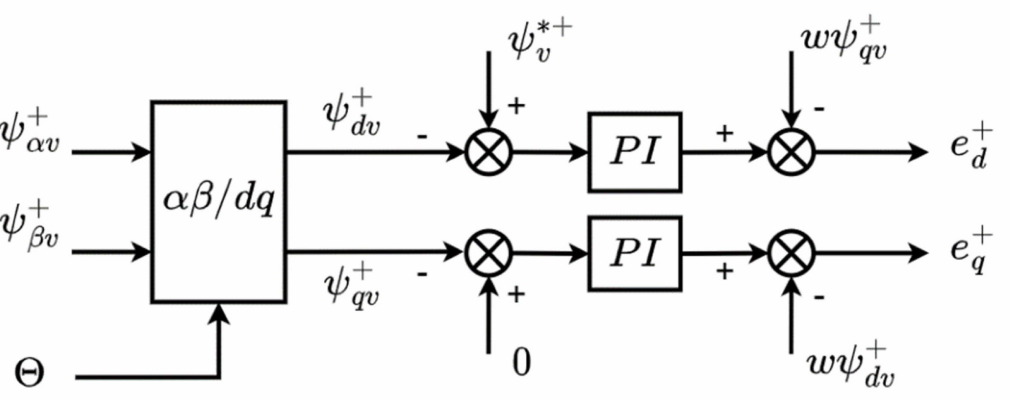
Figure 9. Virtual-flux orientation controller block.